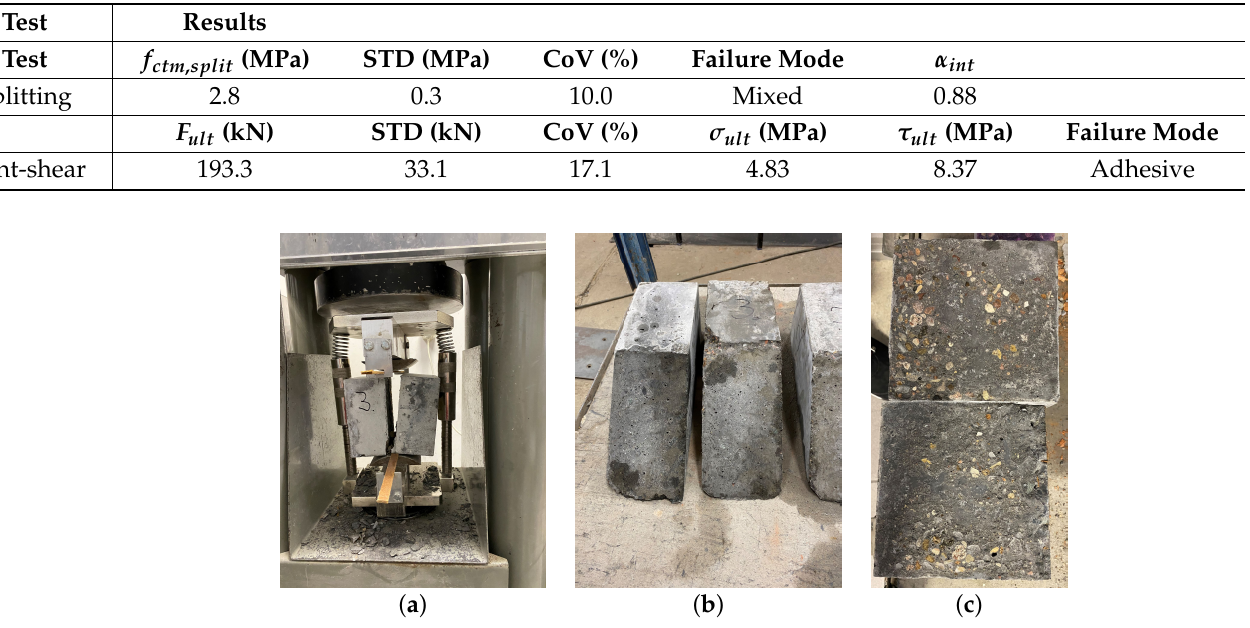
Table 4. Results of the strength tests for the interface.